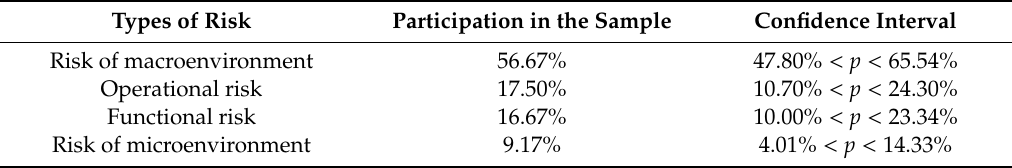
Table 3. Evaluation of risk in the